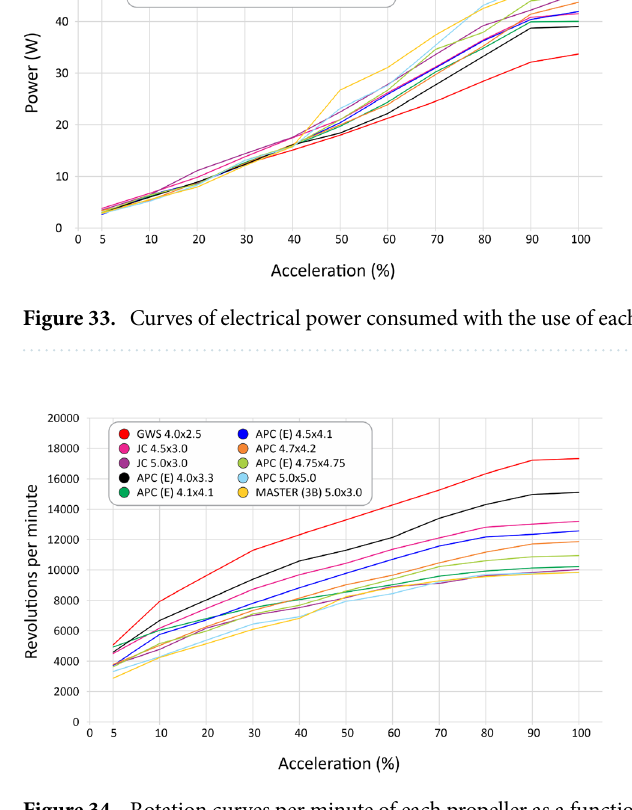
Figure 34. Rotation curves per minute of each propeller as a function of acceleration.